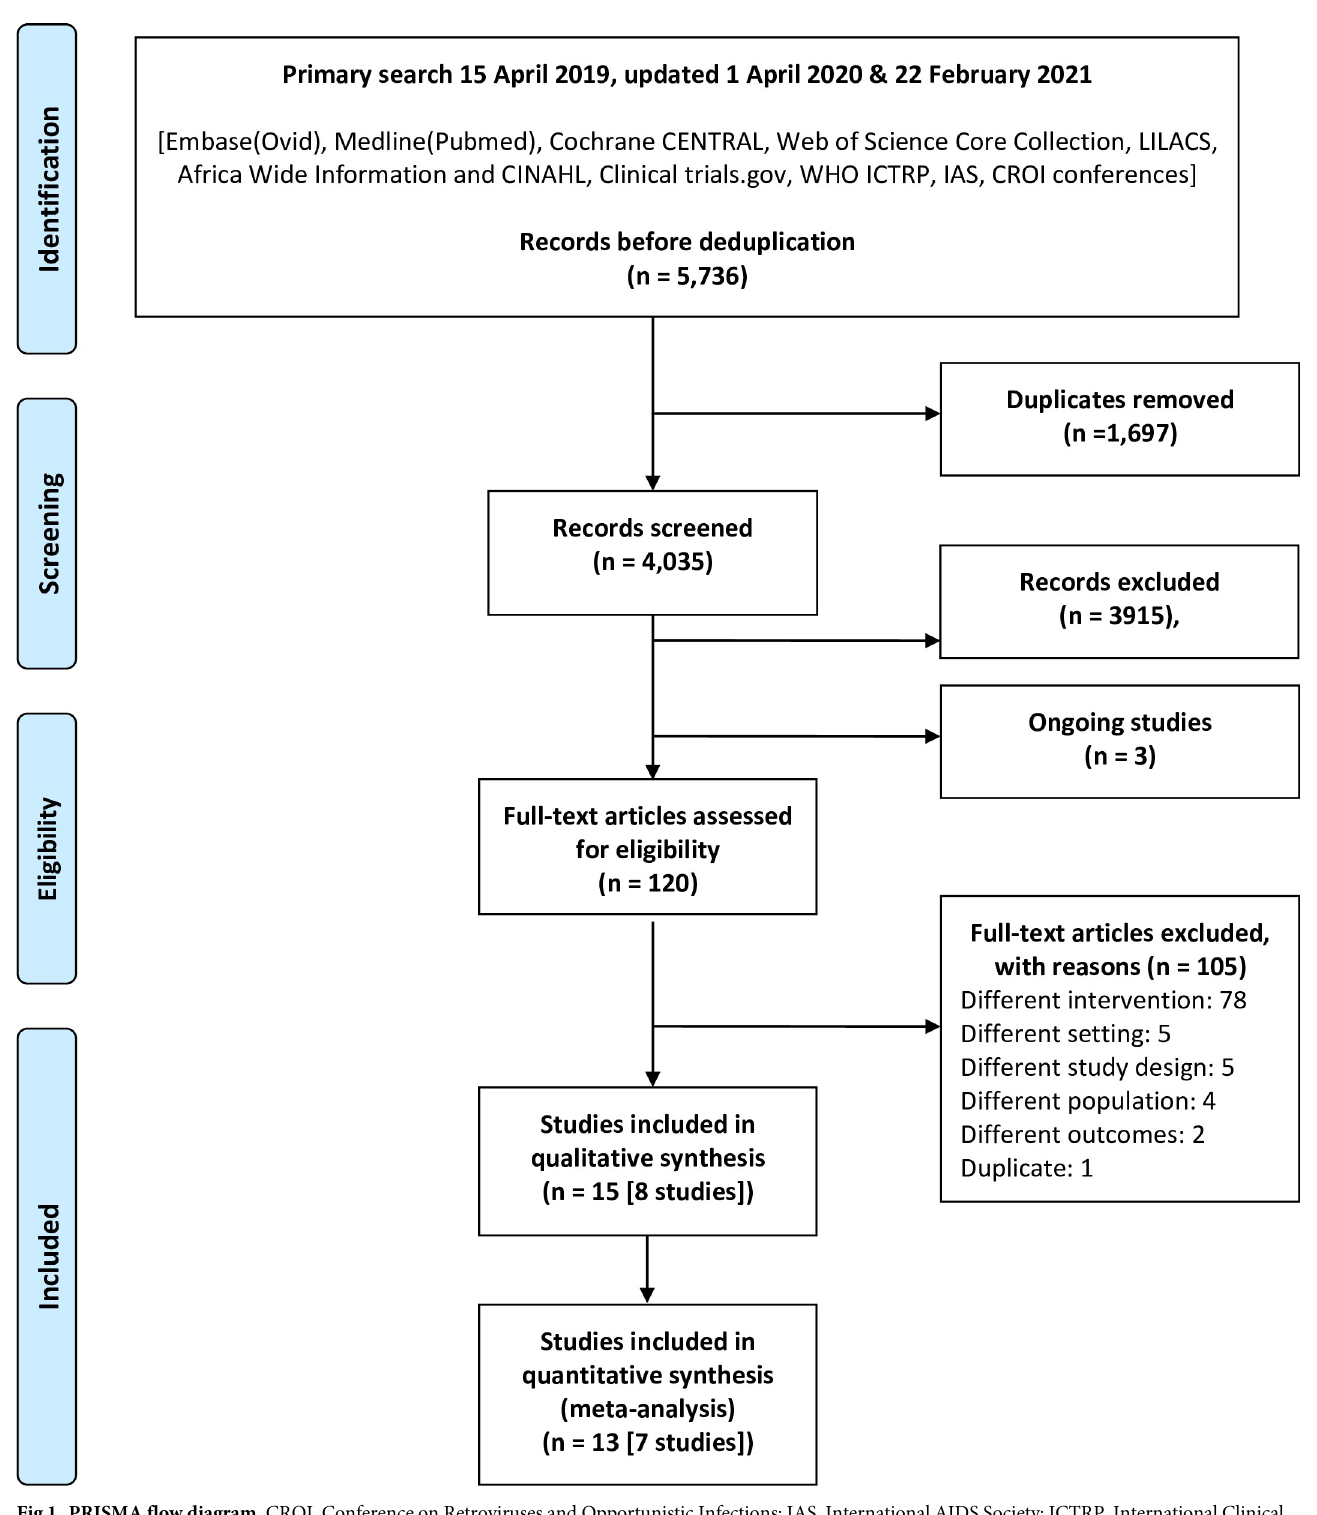
Fig 1. PRISMA flow diagram. CROI, Conference on Retroviruses and Opportunistic Infections; IAS, International AIDS Society; ICTRP, International Clinical Trials Registry Platform.